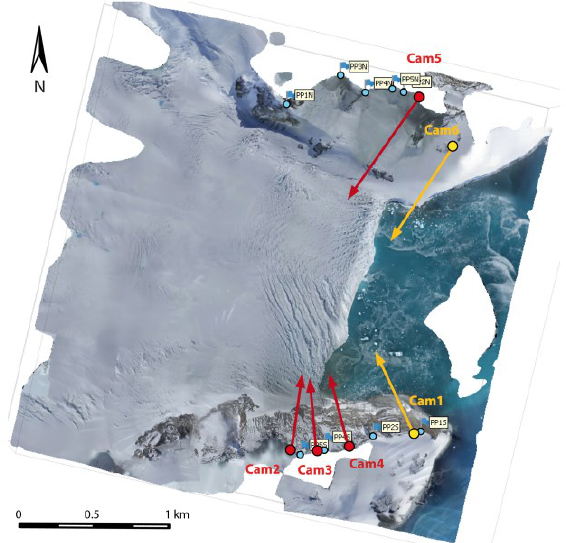
Figure 2: Camera network at Lange Glacier with cameras observing the glacier (red) and the glacier front (yellow); geodetic control points are marked in blue